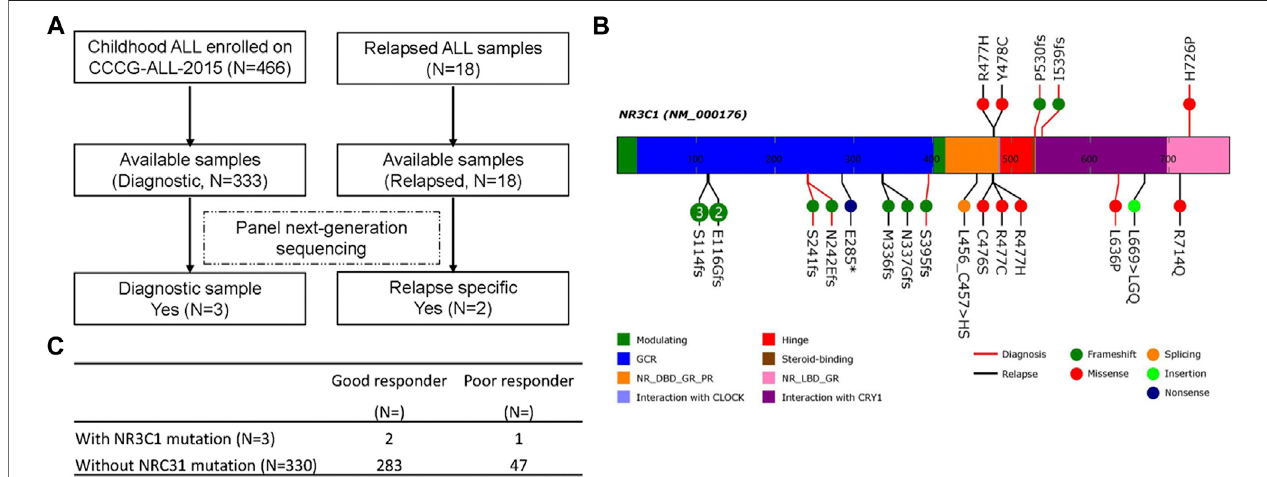
FIGURE 1 | NR3C1 mutations in patients with newly diagnosed and relapsed B-ALL. (A) Identi fi cation of NR3C1 mutations by panel sequencing in patients with newly diagnosed ( N (cid:1) 333) and relapsed ( N (cid:1) 18) B-ALL enrolled in CCCG-ALL-2015 in Guangzhou Women and Children ’ s Medical Center. (B) NR3C1 mutations data from PCGP, cBioPortal, and our hospital were analyzed. NR3C1 mutations spanned the full length of the gene (upper: p. R477H, p. Y478C, p. P530fs, p. I539fs, p. H726P from our hospital; lower: p. S114fs, p. E116Gfs, p. S241fs, p. N242Efs, p. E285*, p.M336fs, p. N337Gfs, p. S395fs, p. L456_C457 > HS, p. C476S, p.